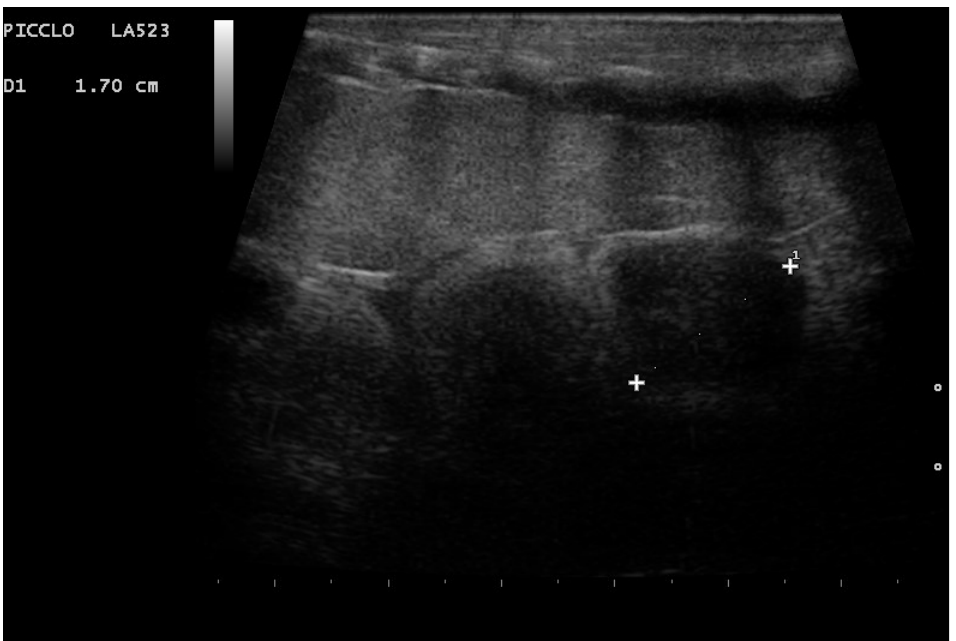
Figure 2. Follicles 17 mm in diameter in a female boa at the beginning of the mating period. Phase recognized in 100% of the subjects involved in the study. The structures no longer appear round and uniformly anechoic but show a nonuniform echogenicity.